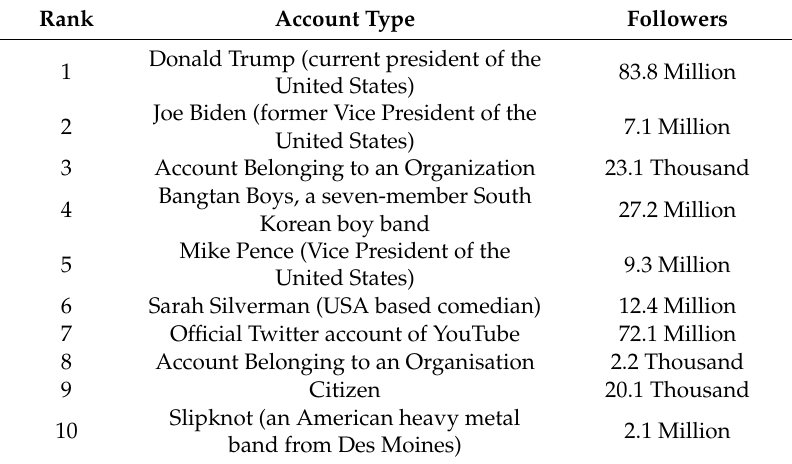
Table 3. Top 10 users most